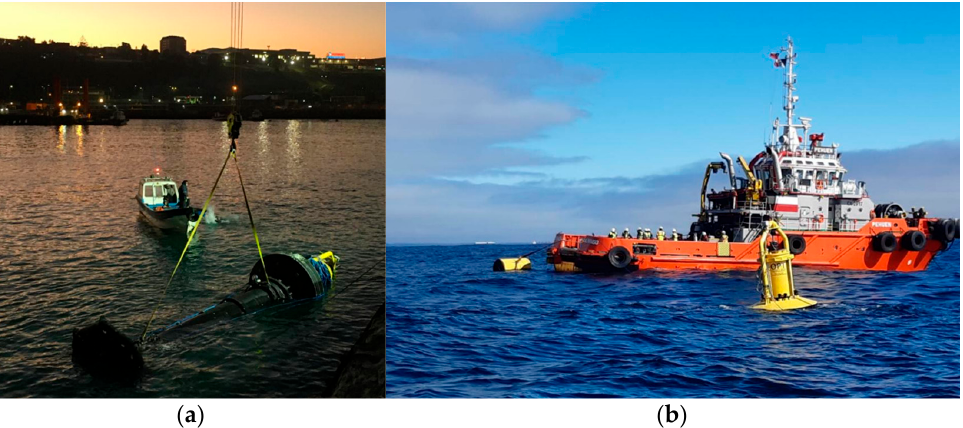
Figure 7. ( a ) Lowering of the PB3 PowerBuoy into the water at San Antonio Port. ( b ) PB3 PowerBuoy deployed at its final position in Cartagena Bay.